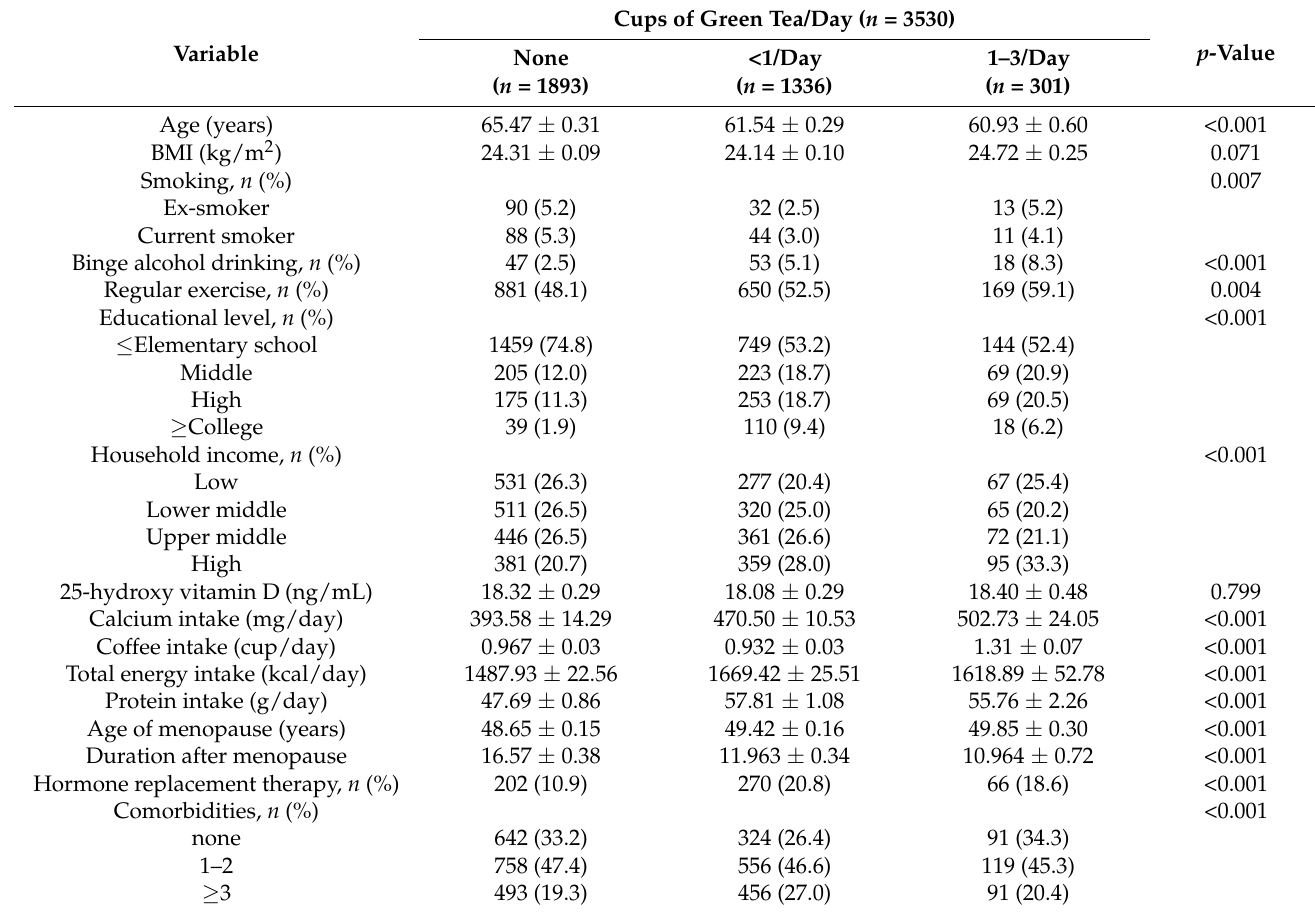
Table 1. General characteristics of study subjects based on their green tea